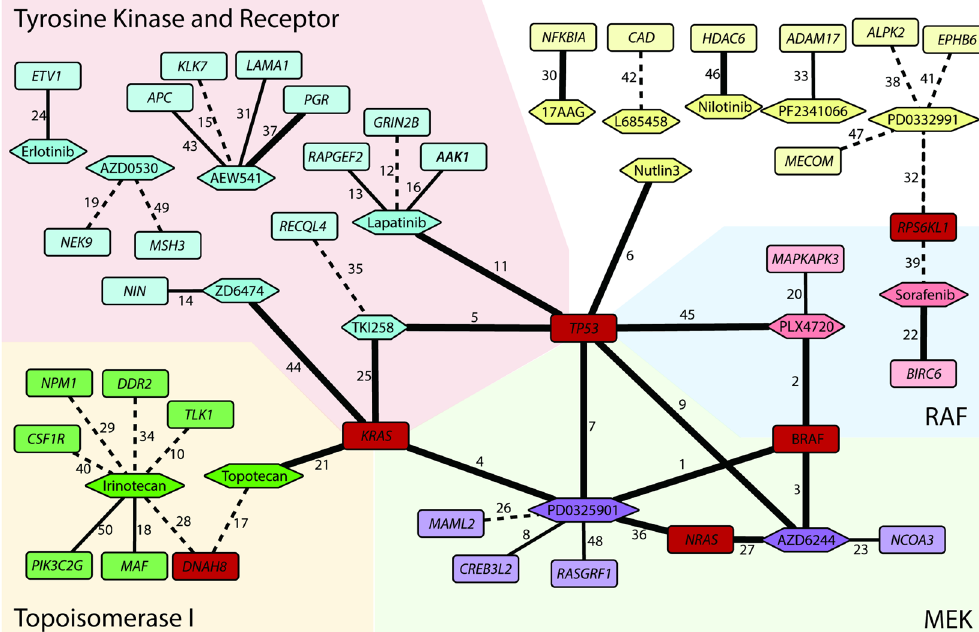
Figure 5. Top 50 drug-mutated gene relationships inferred with direct couplings. Clusters are annotated with different colors based on the pathways to which the targets of drugs belong. Rectangles represent drugs and ellipses are the mutated genes. Red nodes indicate hubs connected to several drugs. Solid lines indicate that the gene product is known to relate with the target of the drug it connects, defined as known interactions , with thick solid edges indicating strong interactions between drug and mutated gene. The thin solid lines indicate a weaker relationship between drug and mutated gene. Dashed edges show predicted interactions between drug and mutated gene that have not been found in the literature. The edge coefficients represent the rank using direct information as a